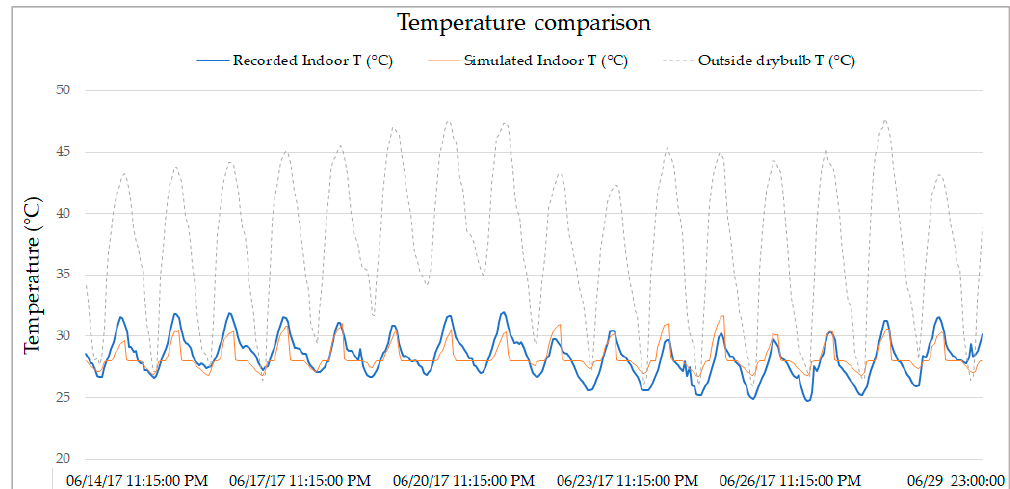
Figure 7. The simulated and recorded indoor temperature profiles for the classroom over 14–30 June.